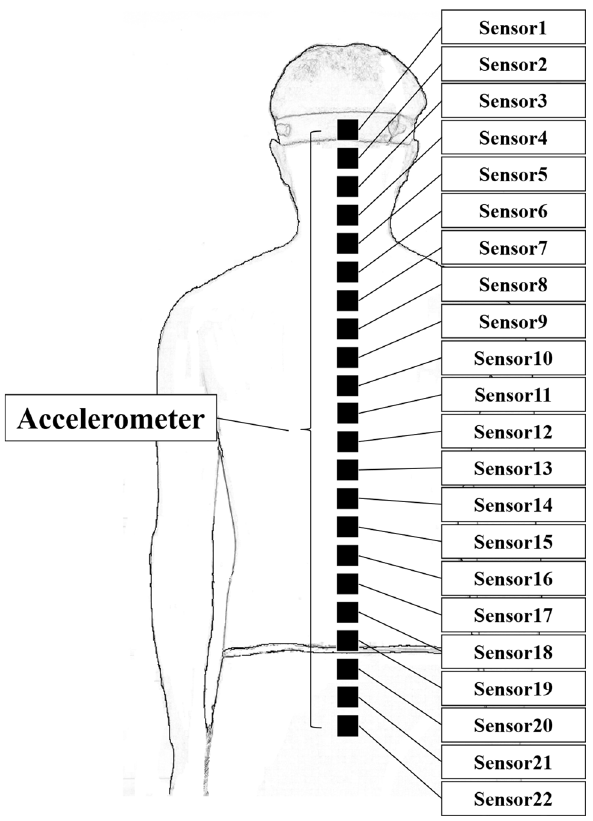
Figure 1. Schematic of 22 accelerometers placement. A triaxial acceleration sensor module was attached at 22 points evenly spaced from the occipital ridge to the